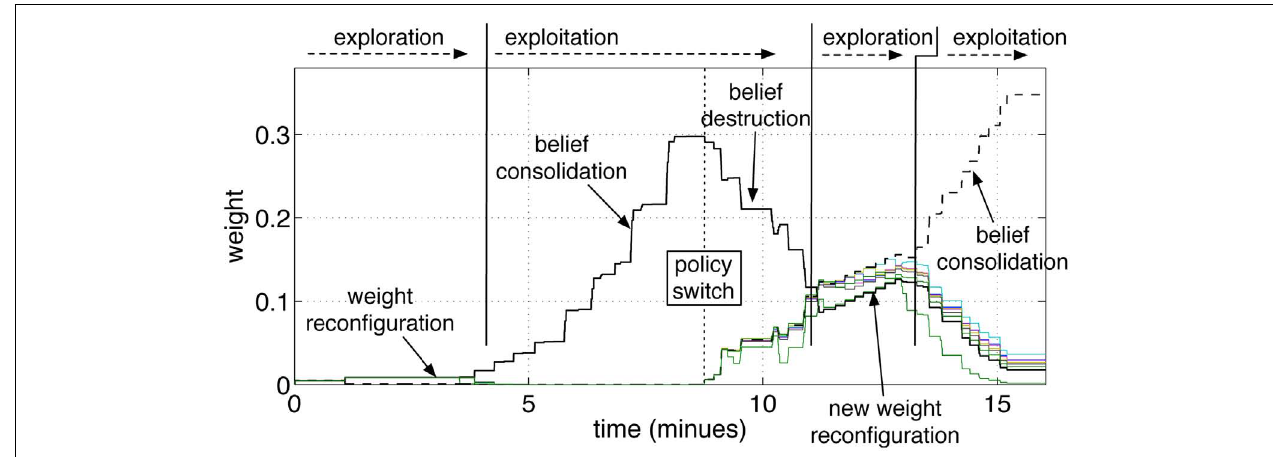
the tutor changes his policy and gives a punishment if the robot perseverates with the previous answer.This leads to a convergence of all weights and to forgetting the previous association. A new exploratory phase then starts, which results in a new exploitation once the new correct color is guessed and the tutor rewards the